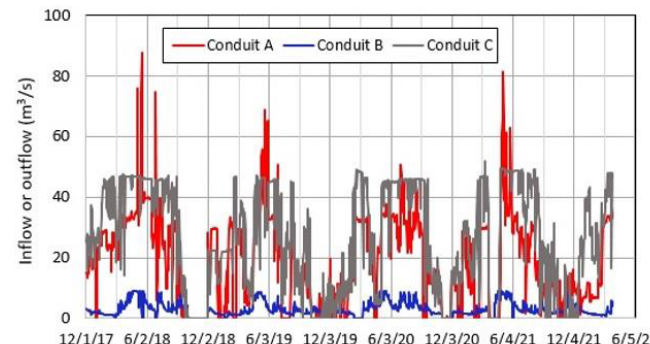
Figure 9. Temporal variations of daily mean inflow at the conduits A and B and daily mean outflow at the conduit C (Figure 1) for 1 December 2017–31 March 2022.